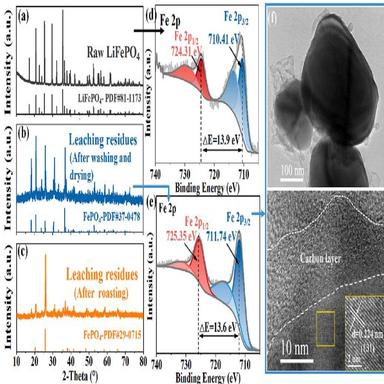
XRD pattern of (a) raw LFP, (b) leaching residues after washing and drying, (c) leaching residues after roasting at 600◦C for 30 min; XPS spectra of Fe 2p of (d) raw LFP and (e) dried leaching residues; TEM image of dried leaching residues (residues were obtained at optimal leaching condition: slurry density of 20 g/L, 80 mmol/L FeSO4, 400 mmol/L H2O2 and leaching time of 10 min).